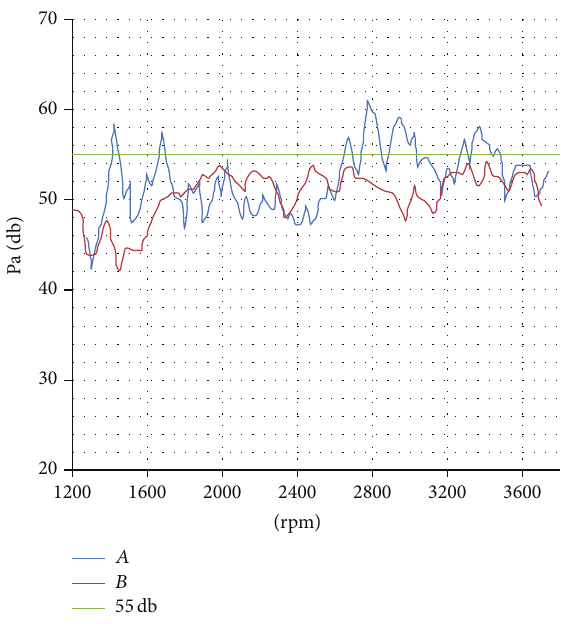
Figure 10: Experimental results: noise test inside vehicle. ( 𝐴 : noise effect; the angle of transmission shafts is 7 ∘ and the intermediate support stiffness is approximately 700 N/mm; 𝐵 : noise effect; the angle of transmission shafts is 5 ∘ and the intermediate support stiffness is approximately 500 Figure 9: Experimental results.